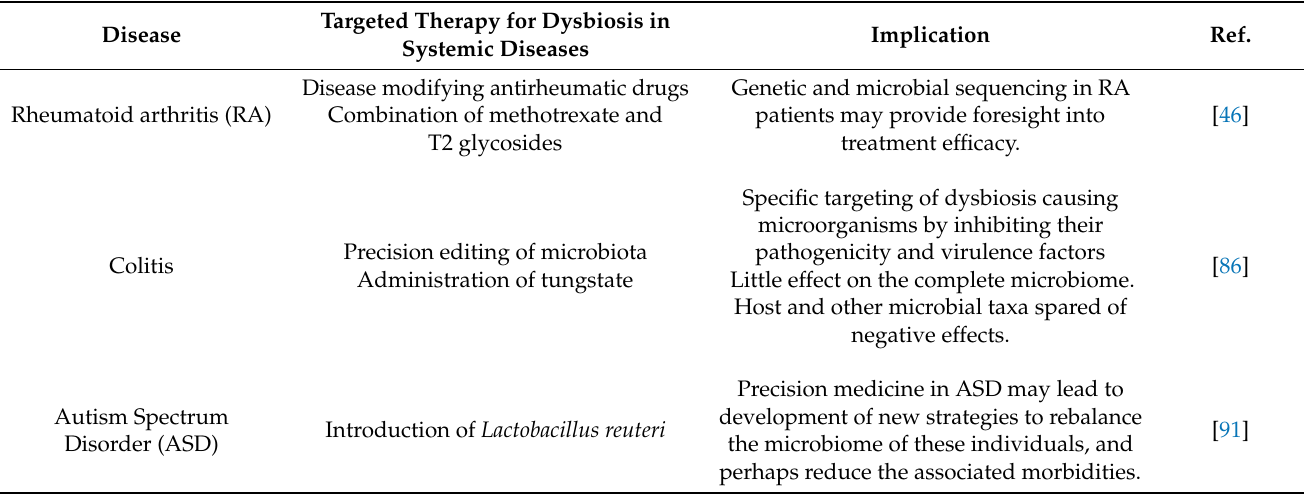
Table 5. Targeted therapy for dysbiosis in systemic